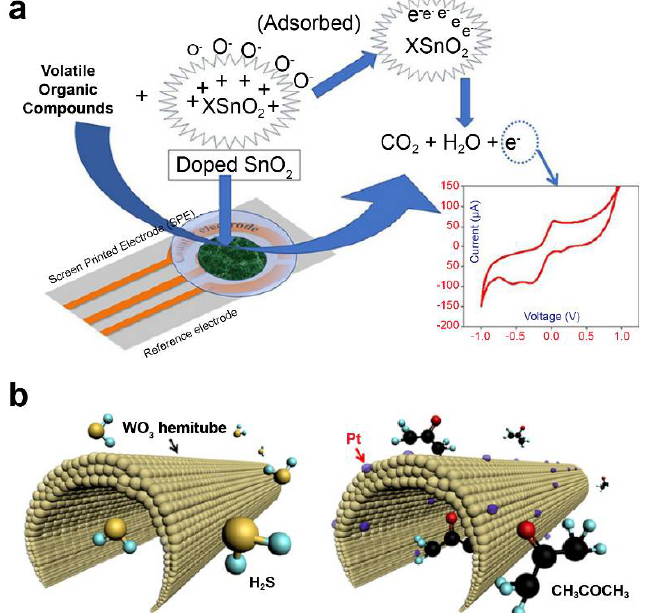
Figure 2. Metal–oxide nanomaterial-based electrochemical sensors. ( a ) Doped SnO 2 nanomaterial sensor for lung cancer diagnosis. Data reproduced from Ref. [101]. Copyrights ACS 2020. ( b ) Diabetes diagnosis model using polycrystalline WO 3 hemi-tube for H 2 S, selective acetone detecting sensors. Data reproduced from Ref. [116]. Copyrights ACS 2013.